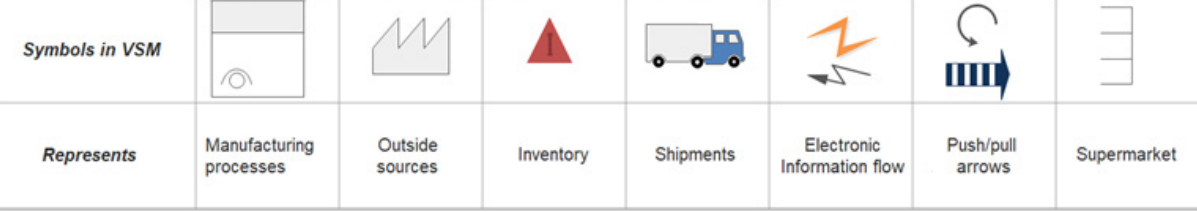
Figure 5. Map of current state. The top part of the map shows the information flows starting from the customer, through internal company communication and ending with suppliers. The material flow is visualized in the lower part. Below it there are tables with individual indicators, where: •